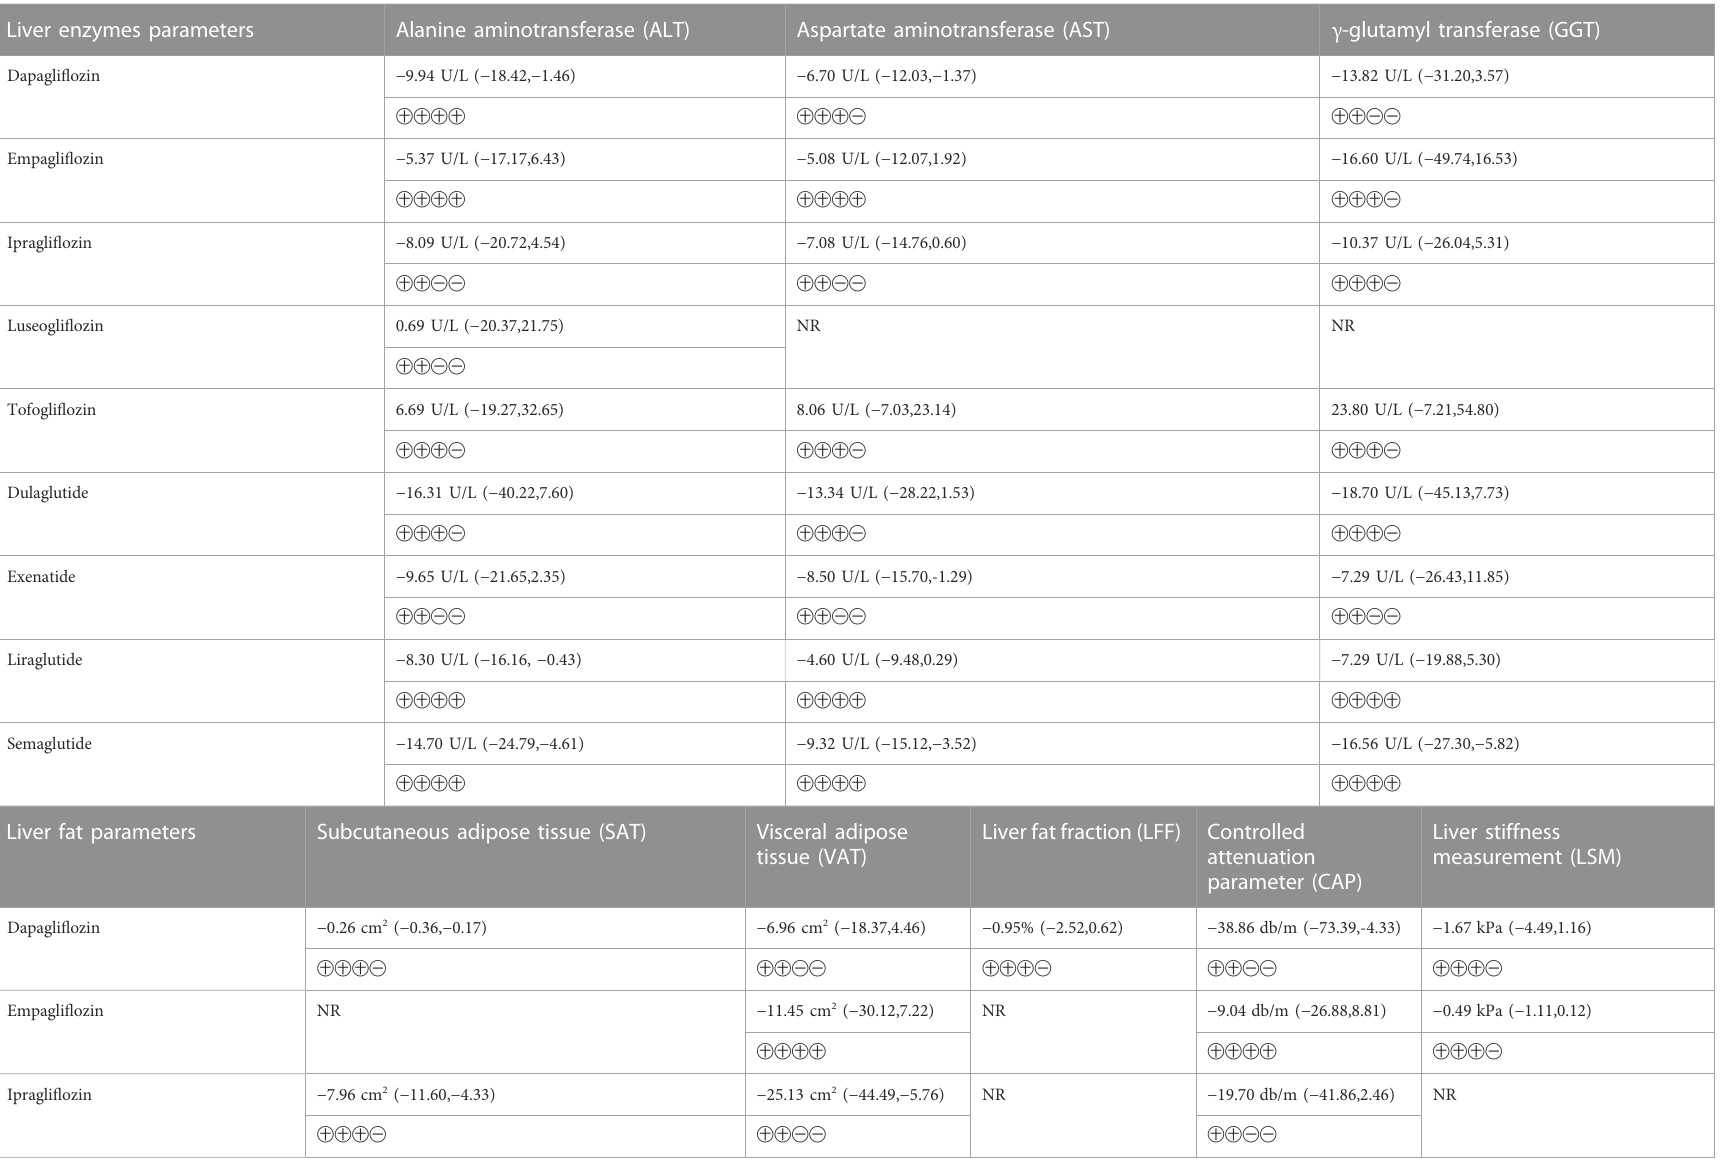
TABLE 1 Summary of anticipated absolute differences in outcomes comparing sodium-glucose cotransporter-2 inhibitor and glucagon-like peptide-1 receptor agonist treatment with placebo treatment. Liver enzymes